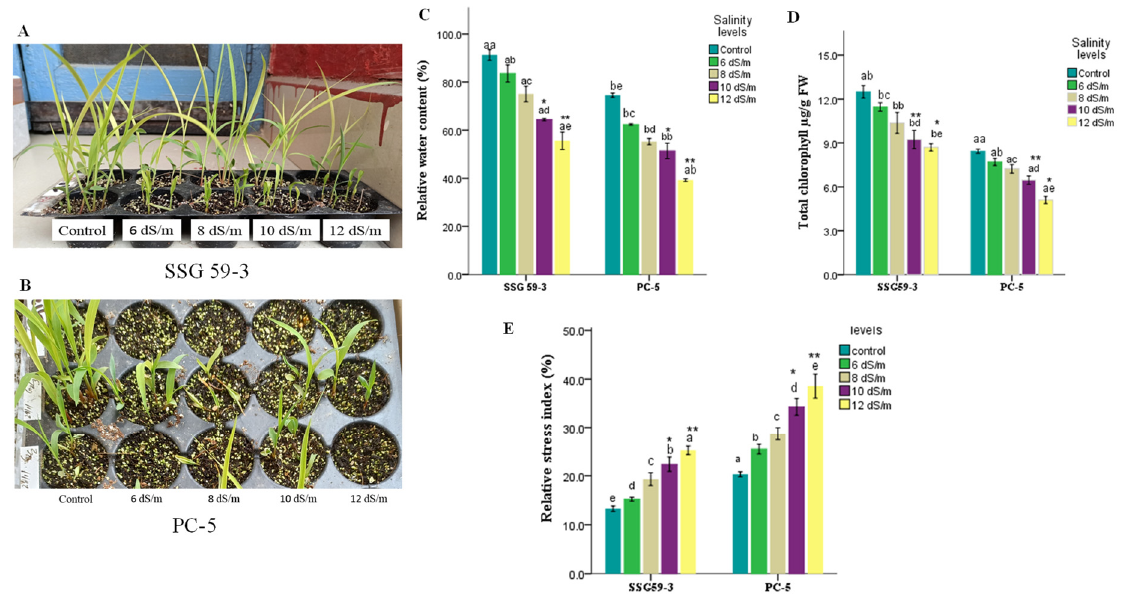
Figure 4. Effect of salt stress on morphological traits of sorghum genotypes. ( A ) Twenty-one-day-old seedlings of salt- tolerant SSG 59-3 after 48 h of salt exposure, ( B ) 21-day-old seedlings of salt-sensitive PC-5 after 48 h of salt exposure. Effect of the salt treatment on ( C ) relative water content (RWC), ( D ) total chlorophyll content, and ( E ) relative stress index. All values are the means ± SD of three biological replicates. Asterisks represent significant (*) and highly significant (**) differences among different treatments. a–e Values with different superscripts in the same row are significantly different at p <